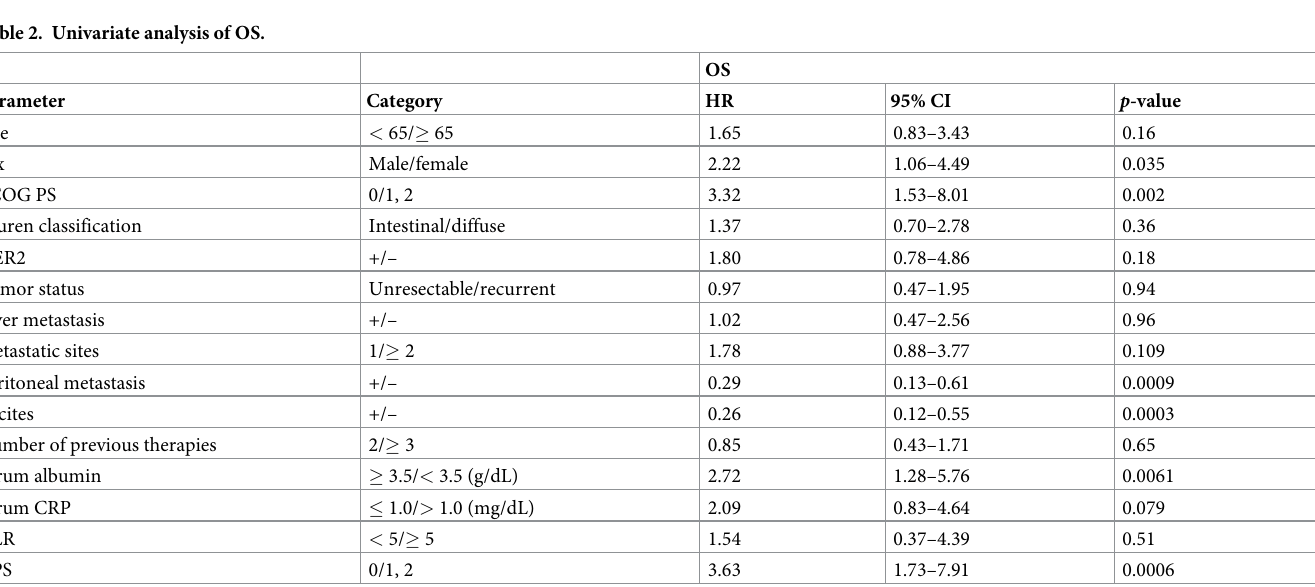
Table 2. Univariate analysis of